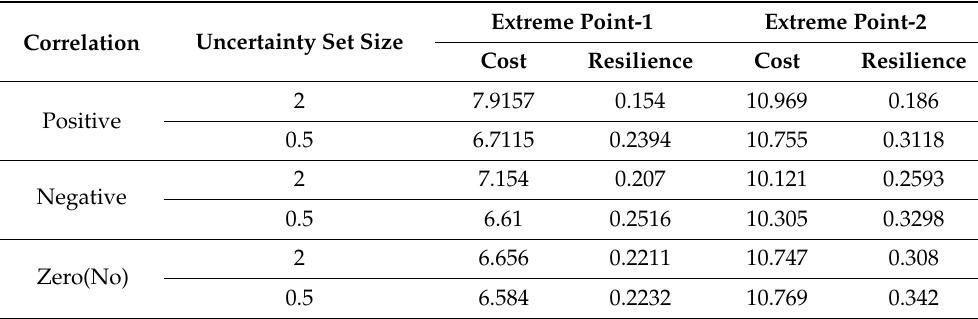
Table 3. Cost and resilience comparison of extreme points in the Pareto front for two different uncertainty set sizes.